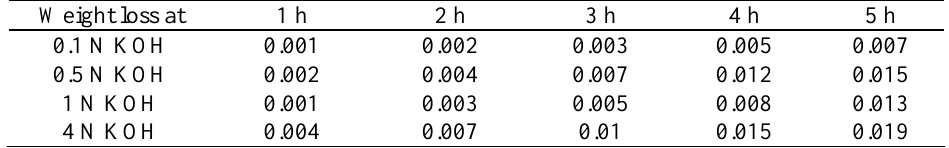
Table 14 .Weight loss of brass in